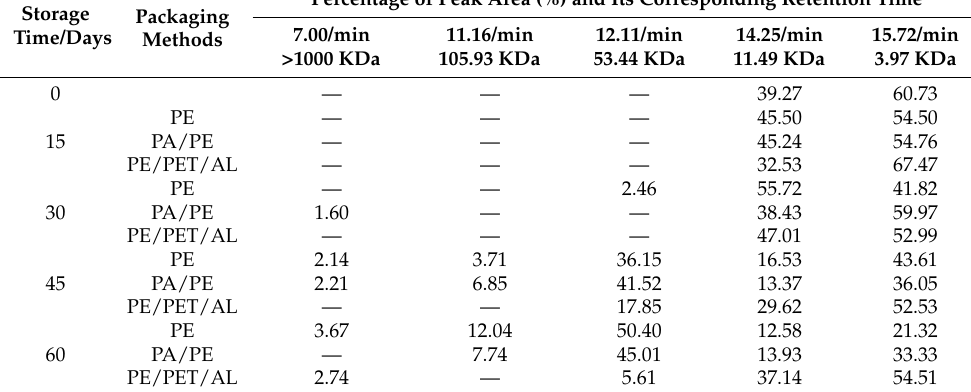
Figure 7. Molecular weight distribution analysis of walnut protein isolate under different storage condi- tions (( A ) PE-sealed packaging; ( B ) PA/PE vacuum packaging; ( C ) PE/PET/AL vacuum packaging). Table 2. Percentage of peak area of molecular weight distribution of walnut protein isolate under different storage